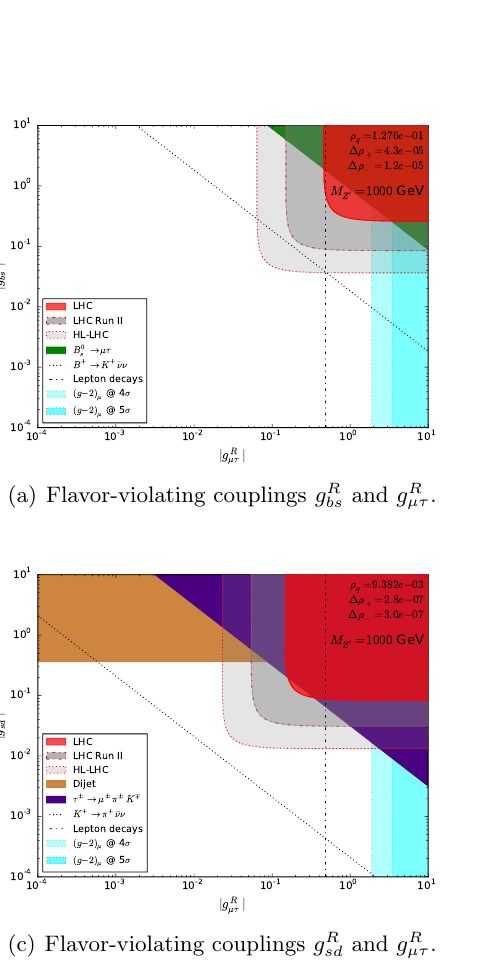
Figure 22 . Flavor-violating couplings in the (cid:22)(cid:28) sector for a Z 0 boson of M Z 0 = 1 TeV. The red p areas depict the limits from the ATLAS analysis of the process pp ! (cid:22)(cid:28) at s = 8 TeV. The red dash-dotted and dashed lines are projections to the LHC Run II and HL-LHC. The brown areas show four-quark contact interaction limits from LHC dijet analyses [15]. The green areas are the limits coming from meson decays into charged leptons. In purple we show the bounds from the rare decay (cid:28) (cid:0) ! (cid:22) (cid:0) (cid:25) + K (cid:0) only applicable in the sd sector. The light and dark cyan areas depict the 4 and 5 (cid:27) exclusion bands from (cid:1) a (cid:22) . The black dotted lines are meson decay limits into neutrinos and the black dash-dotted line the limits from lepton decays. These last two limits, however, apply only for left-handed lepton couplings g L instead of g R . The meson decay limits into neutrinos are (cid:22)(cid:28) (cid:22)(cid:28) absent in the cu sector